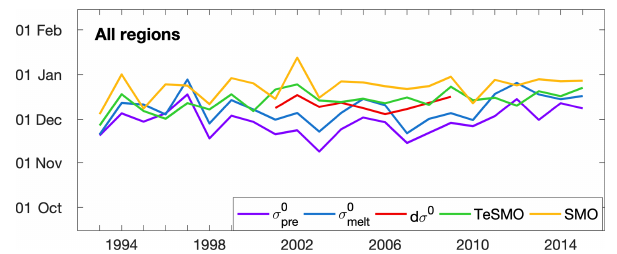
Figure 8. Time series of snowmelt onset dates averaged for all regions derived from backscatter time series ( σ 0 and diurnal backscatter variations (d σ 0 ) , as well as the Temporary Snowmelt Onset (TeSMO) and Continuous Snowmelt Onset (SMO) derived from passive microwave